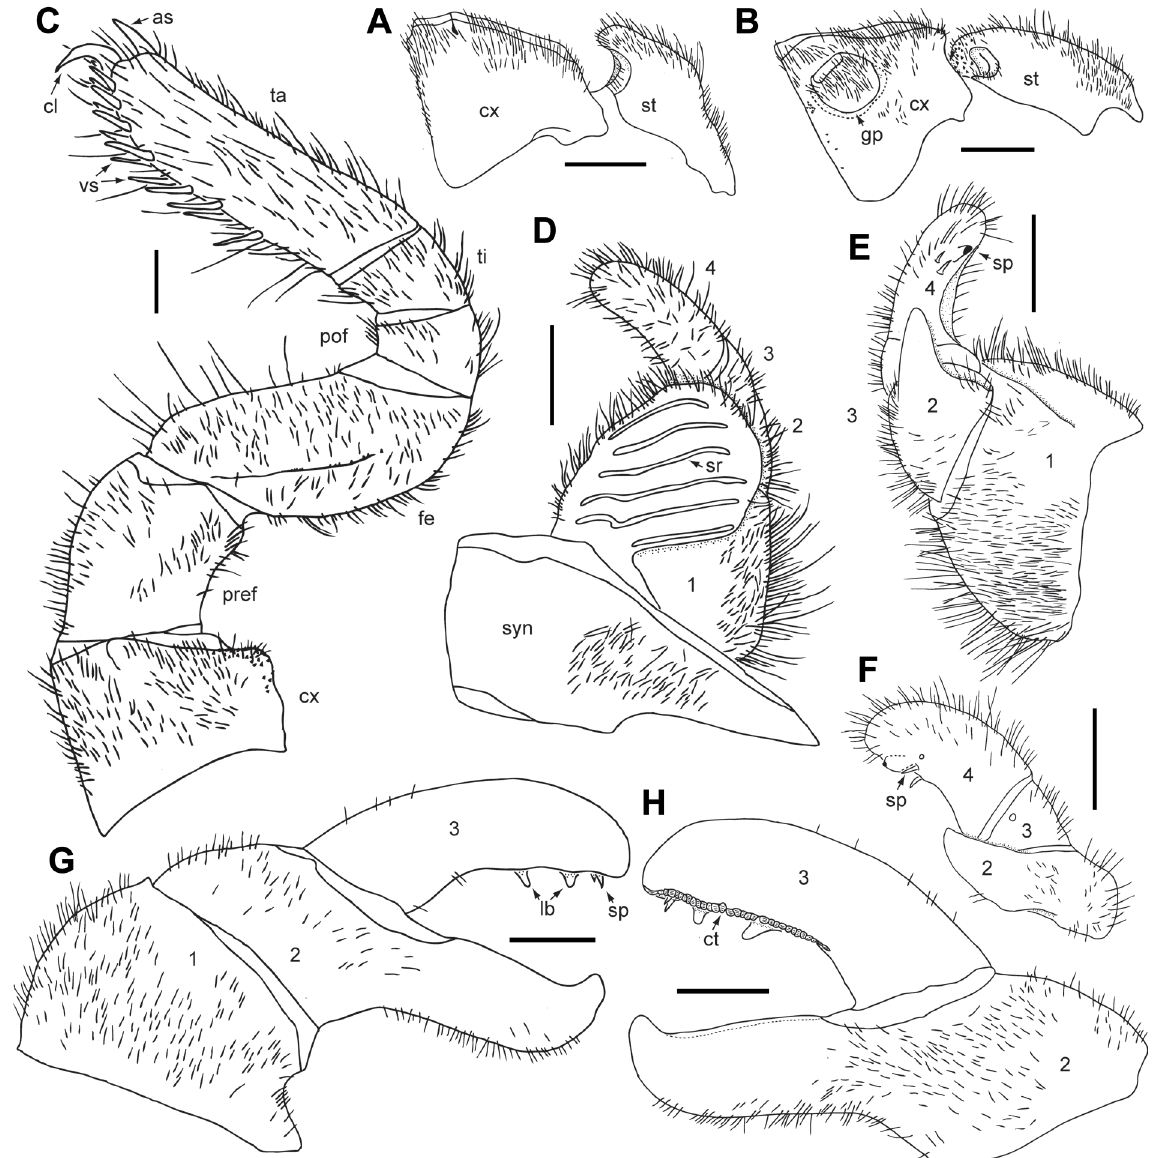
Fig. 9. Sphaeromimus midongy sp. nov., schematic drawing, ♂, holotype ( FMNH-INS 3119888). A . 1 st left coxae and stima carrying plate. B . 2 nd left coxae and stigma carrying plate. C . 9 th left leg. D . Anterior view of right anterior telopod. E . Posterior view of right anterior telopod. F . Lateral view of right anterior telopod. G . Left posterior telopod, anterior view. H . Posterior view of left posterior telopod. Abbreviations: as = anterior spine; cl = claw; ct = crenulated teeth; cx = coxa; fe = femur; gp = gonopore; lb = lobe; pof = postfemur; pref = prefemur; sp = spine; sr = stridulation rib; st = stigmatic plate; syn = syncoxite; ta = tarsus; ti = tibia; vs = ventral spine; 1–4 = podomeres. Scale bars = 1